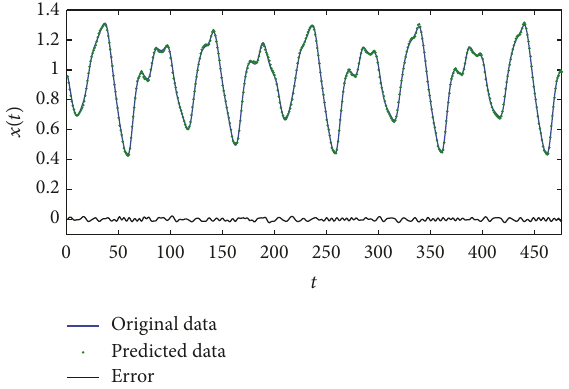
Figure 4: Prediction result with the quasi-ARX RBFN